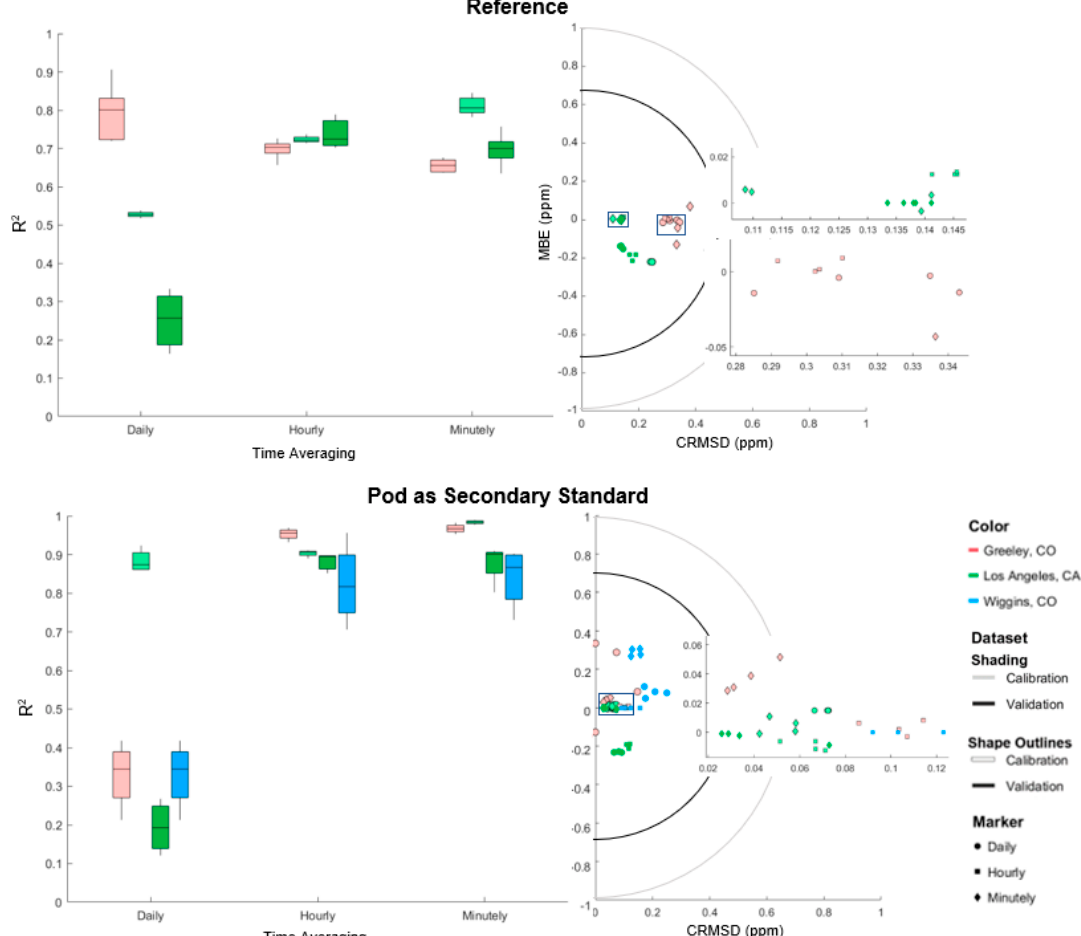
Figure 10. Methane R 2 boxplot ( left ) and MBE vs. CRMSD target plot ( right ) for time averaging of co-located “hop” using the one-hop method as tabulated against a regulatory-grade reference instrument and an individually calibrated pod utilized as a secondary standard. Within each box-and whisker column, the data is as follows from left to right: Greeley calibration, Los Angeles calibration, Wiggins validation (bottom plot only), and Los Angeles